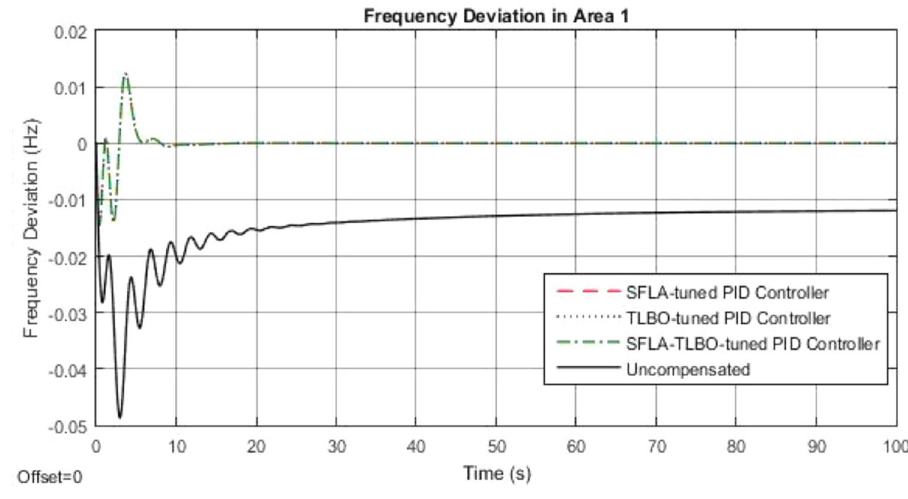
Fig. 8 Frequency deviation in area 2 for two-area